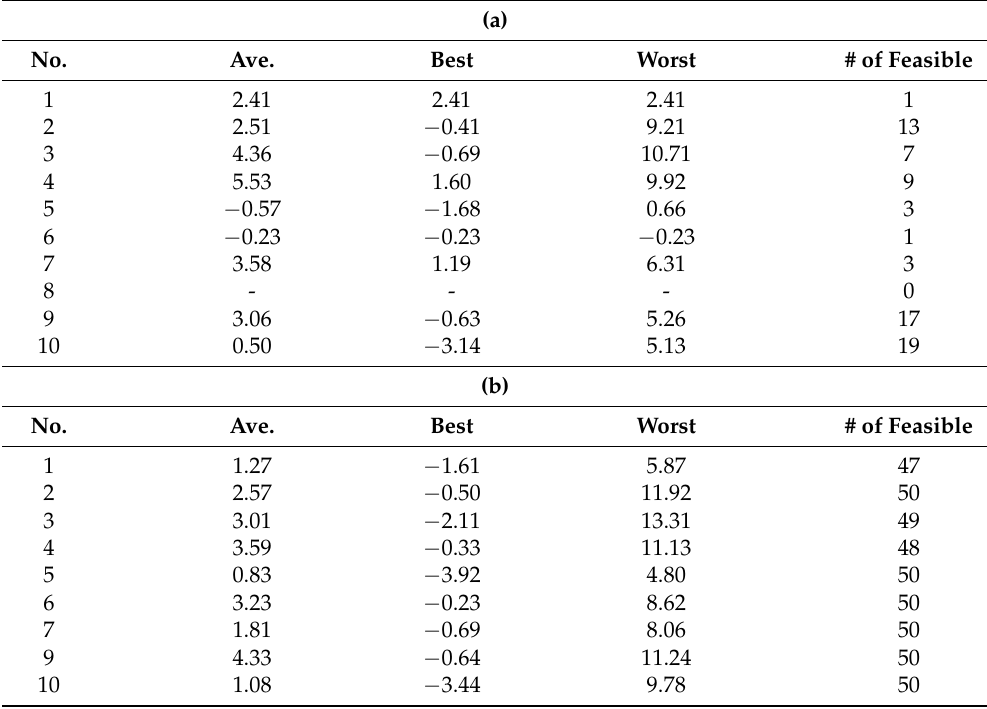
Table 6. Results of the method using fixed values of weight parameters for n = 50. Symbol “-” means that no feasible solutions can be obtained. Negative values of average and best gaps mean that the method can find better solutions than that found by using Gurobi optimizer 9.1.1 within 12